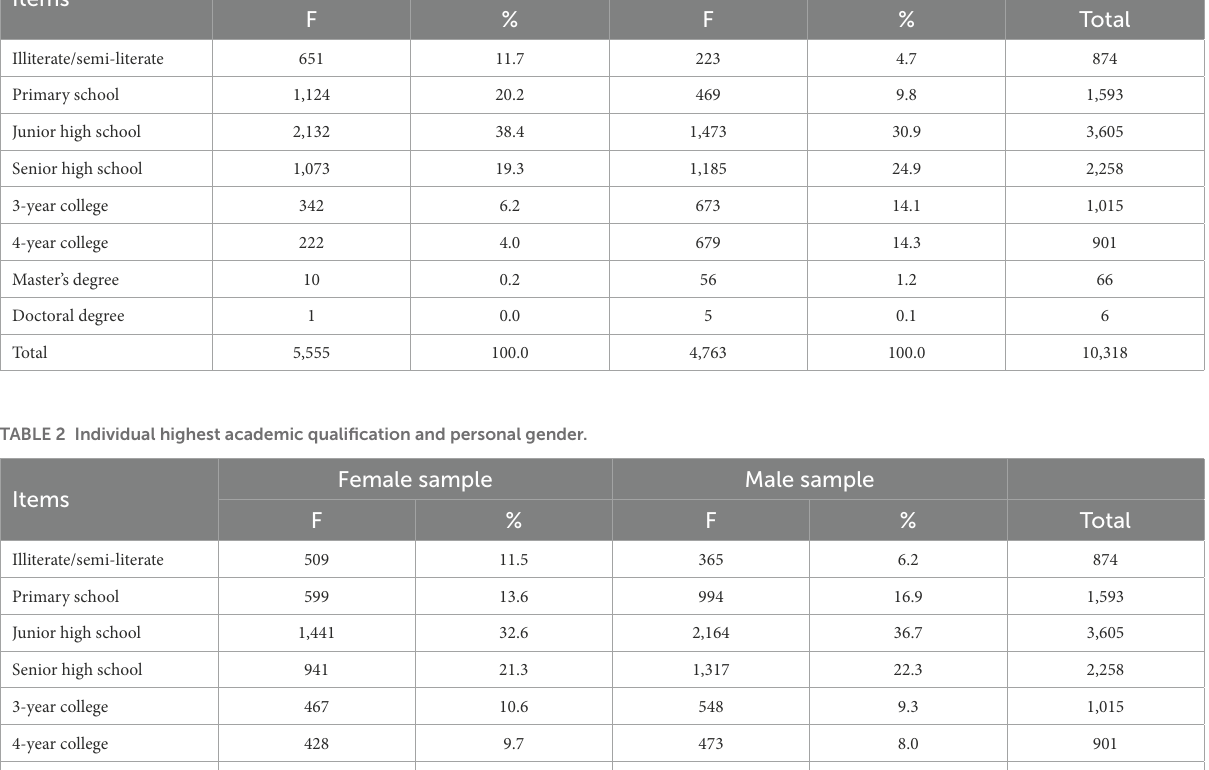
TABLE 1 Individual highest academic qualification and urban/rural classification variables based on data from the National Bureau of Statistics. Rural sample Urban sample Items F